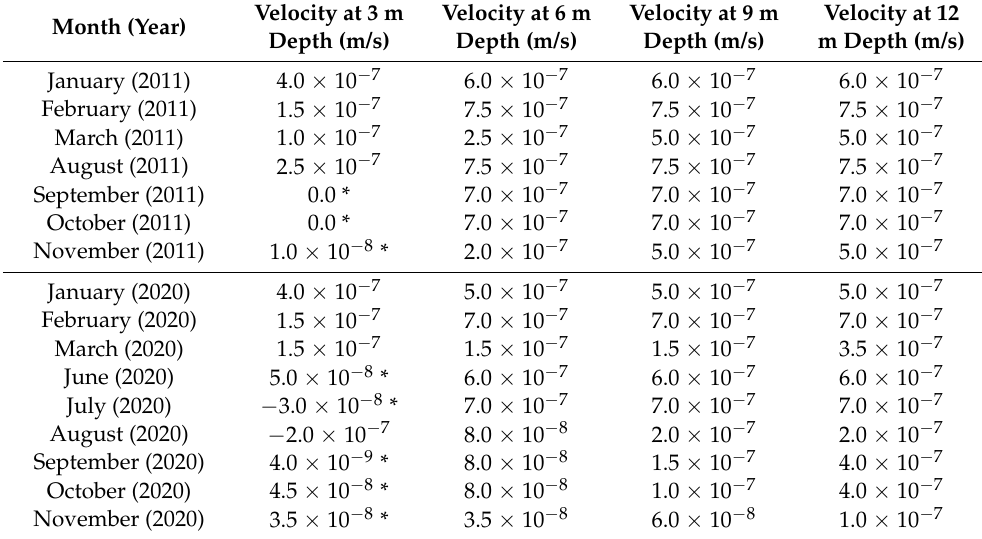
Table 4. Selected velocities for every depth according to the protocol in P-II for scenarios 5 (2011) and 6 (2020). The symbol [*] refers to results of limited